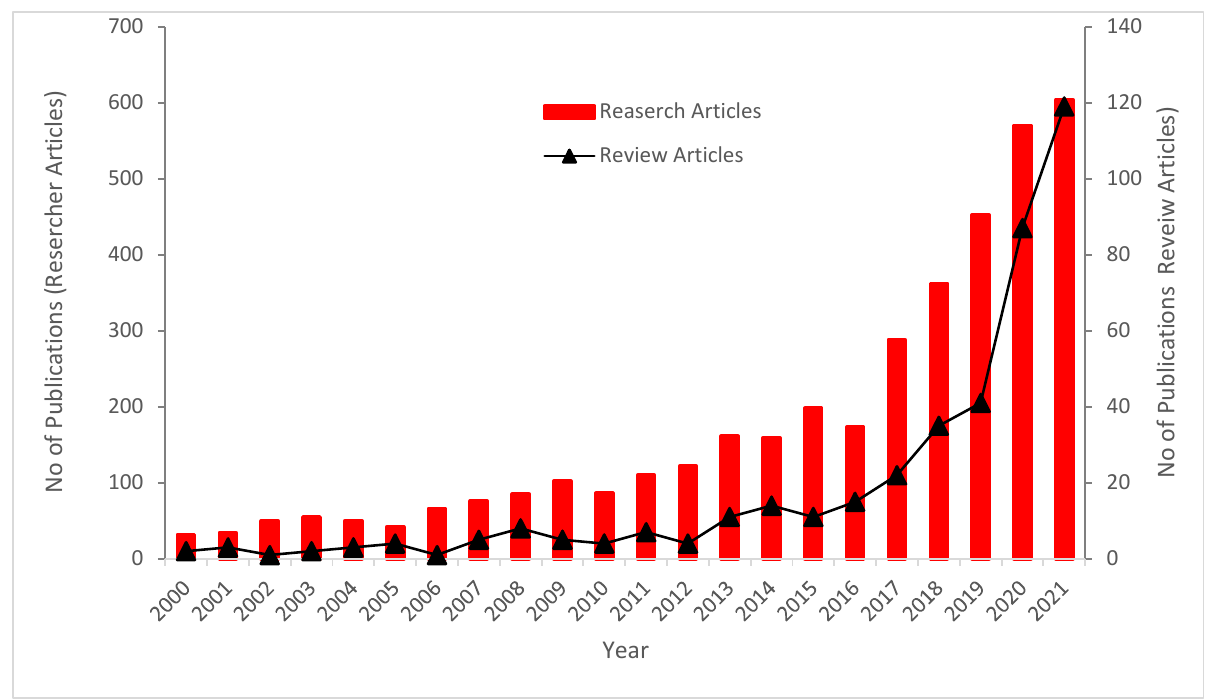
Figure 2. No of the Articles published from 2000 to 2021 on Recycling Plastic Waste: Data source [21].